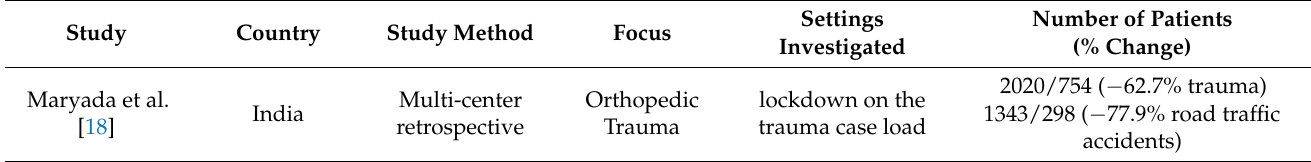
Table 5. Characteristics of relevant publications on orthopedic performance in